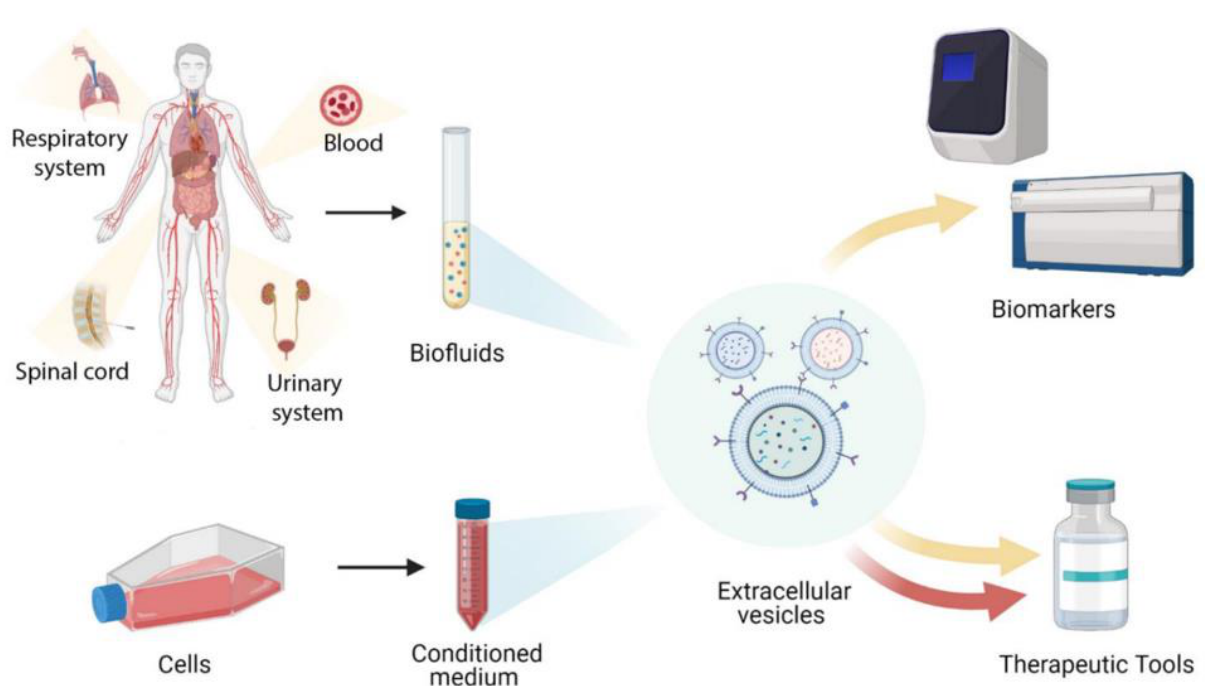
Figure 2. Schematic diagram of various sources of MSCs and their EVs that carrying cargo.